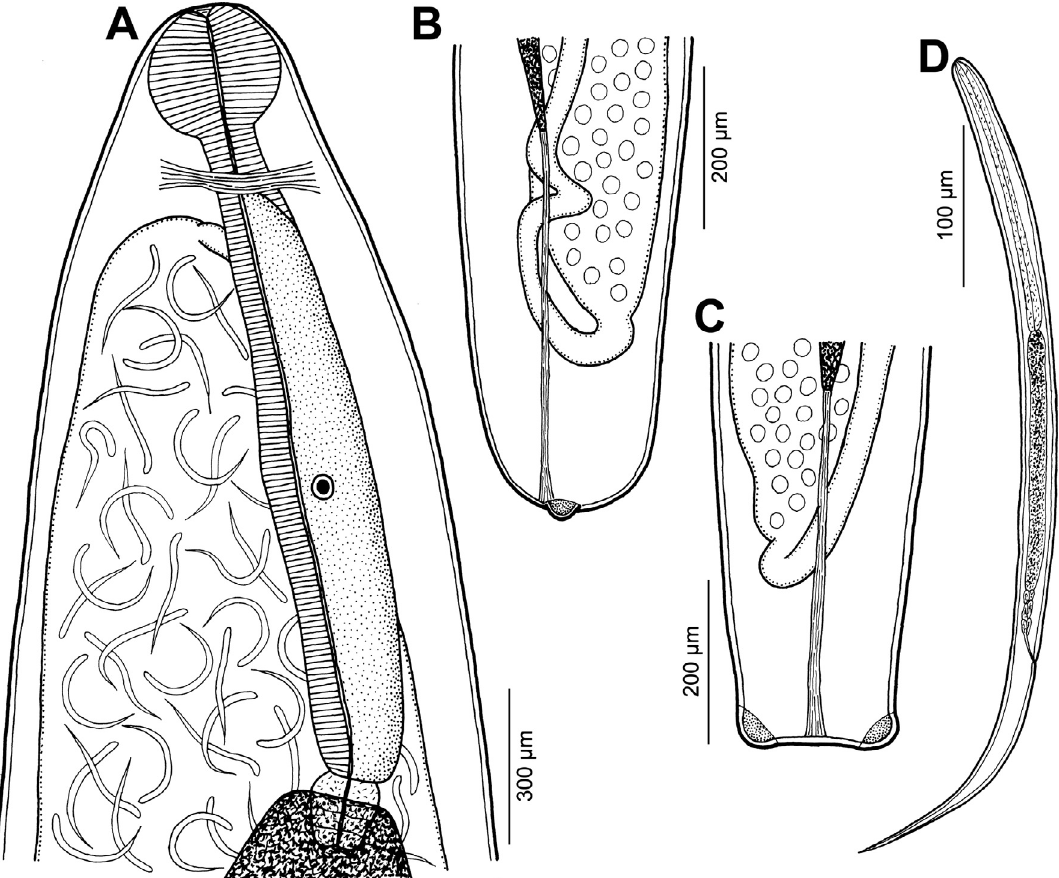
Figure 4. Philometra sp. from Lutjanus johnii . A: Anterior end of largest gravid female, lateral view. B, C: Posterior end of smaller gravid female, lateral and dorsoventral views. D: Larva from uterus, lateral